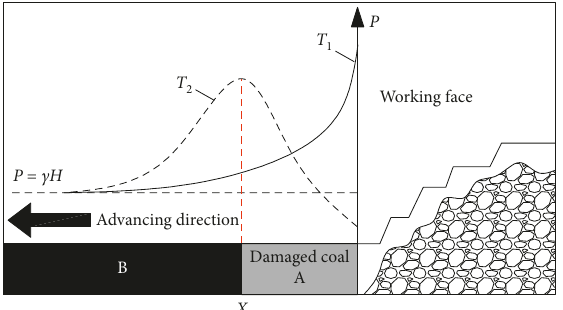
Figure 4: Schematic diagram of mining.